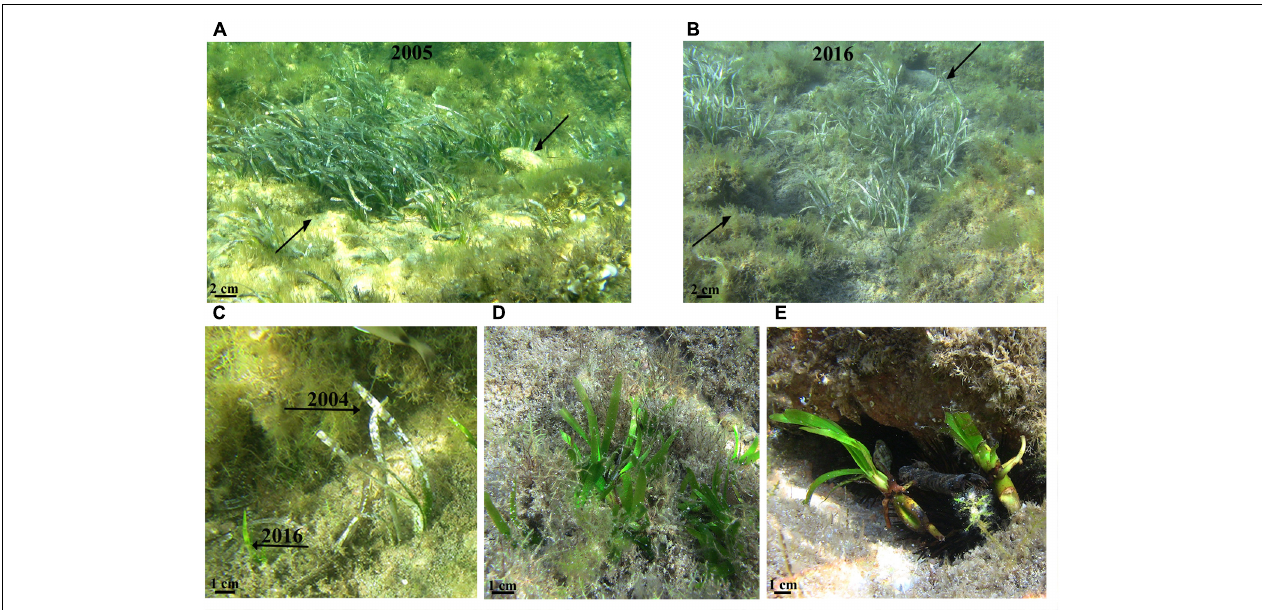
FIGURE 2 | Seedlings of P. oceanica established in the Gulf of Ventilegne (Corsica, France). A patch of seedlings established in 2004 on a sandy substrate patch and marked (arrows) in July 2005 (A) and the same patch photographed after 11 years in July 2016 (B) . Newly established seedlings (2016s cohort) found on sandy substrate very close to old seedlings (2004s cohort) (C) , on rocky pools (D) , and on the aboral surface of sea urchins Paracentrotus lividus (E) .